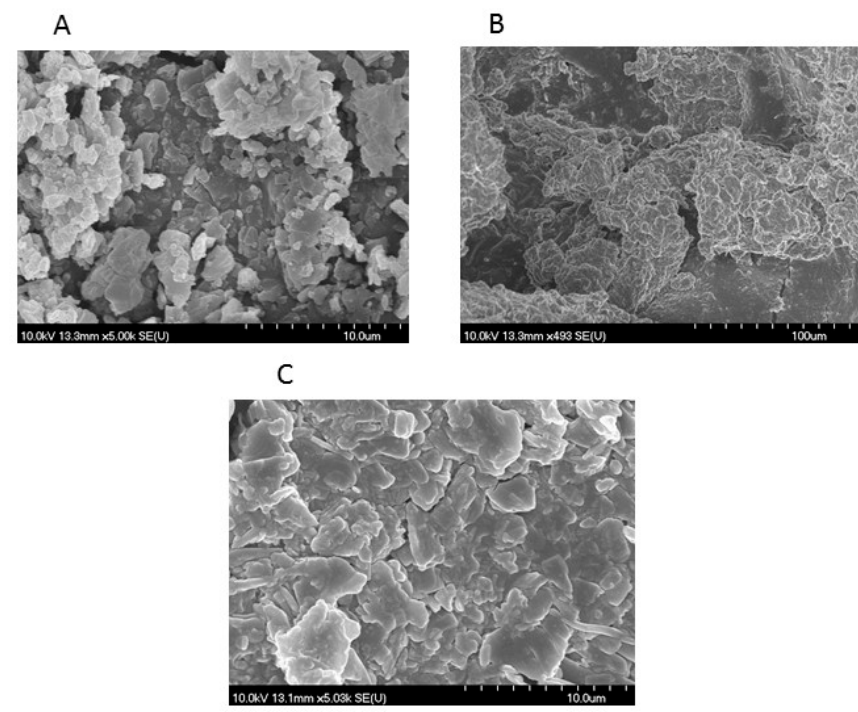
Molecules 2020 , 25 , x FOR PEER REVIEW Figure 5. SEM microphotographs, ( A )—ABZ; ( B )—empty PU structures; ( C )—ABZ-PU particles.